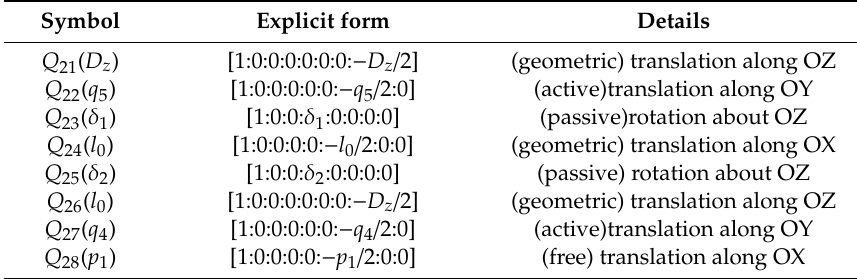
Table 3. The study parameters used in the motion parameterization of the upper planar mechanism. Symbol Explicit form Details